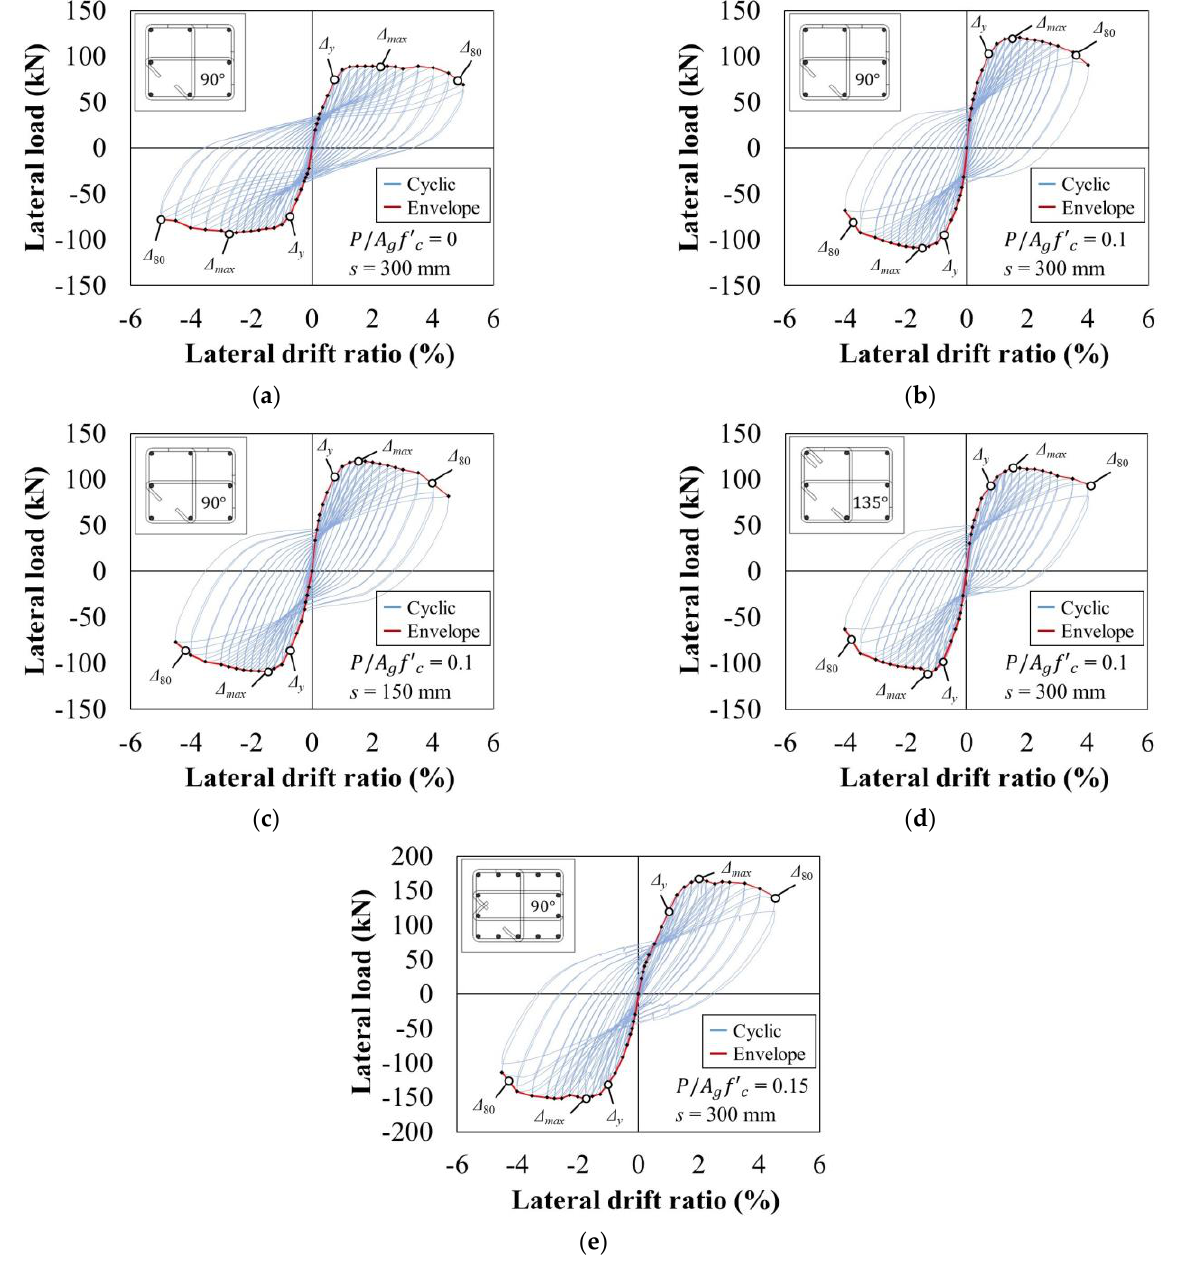
Figure 4. Lateral load – drift hysteresis curves of specimens: ( a ) C1; ( b ) C2; ( c ) C3; ( d ) C4; ( e ) C5. Table 2. Summary of test results.